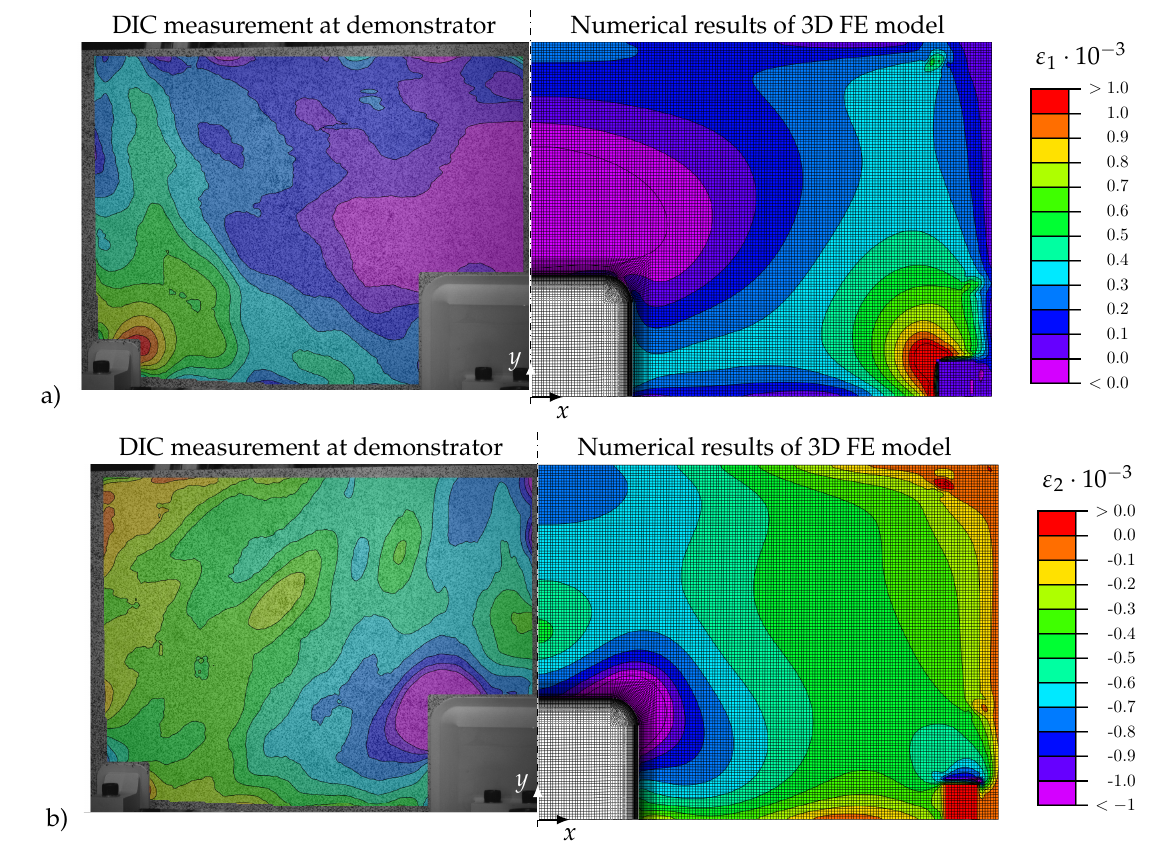
Figure 11. Comparison between the experiment and simulation of ( a ) minor and ( b ) major principal in-plane strains at an applied load of F =